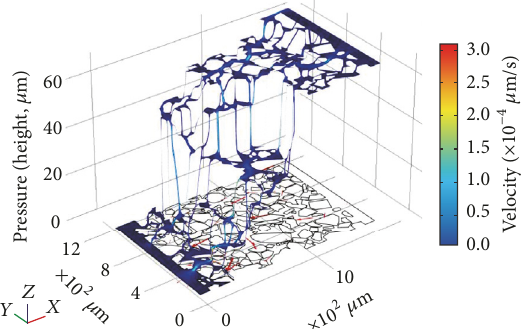
Figure 8: Simulation results of pore pressure decline of Sample 1.